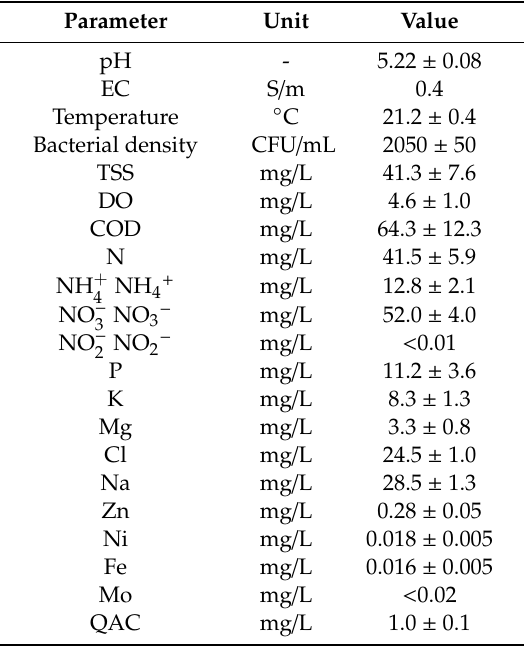
Table 3. Aquaculture wastewater characterization.